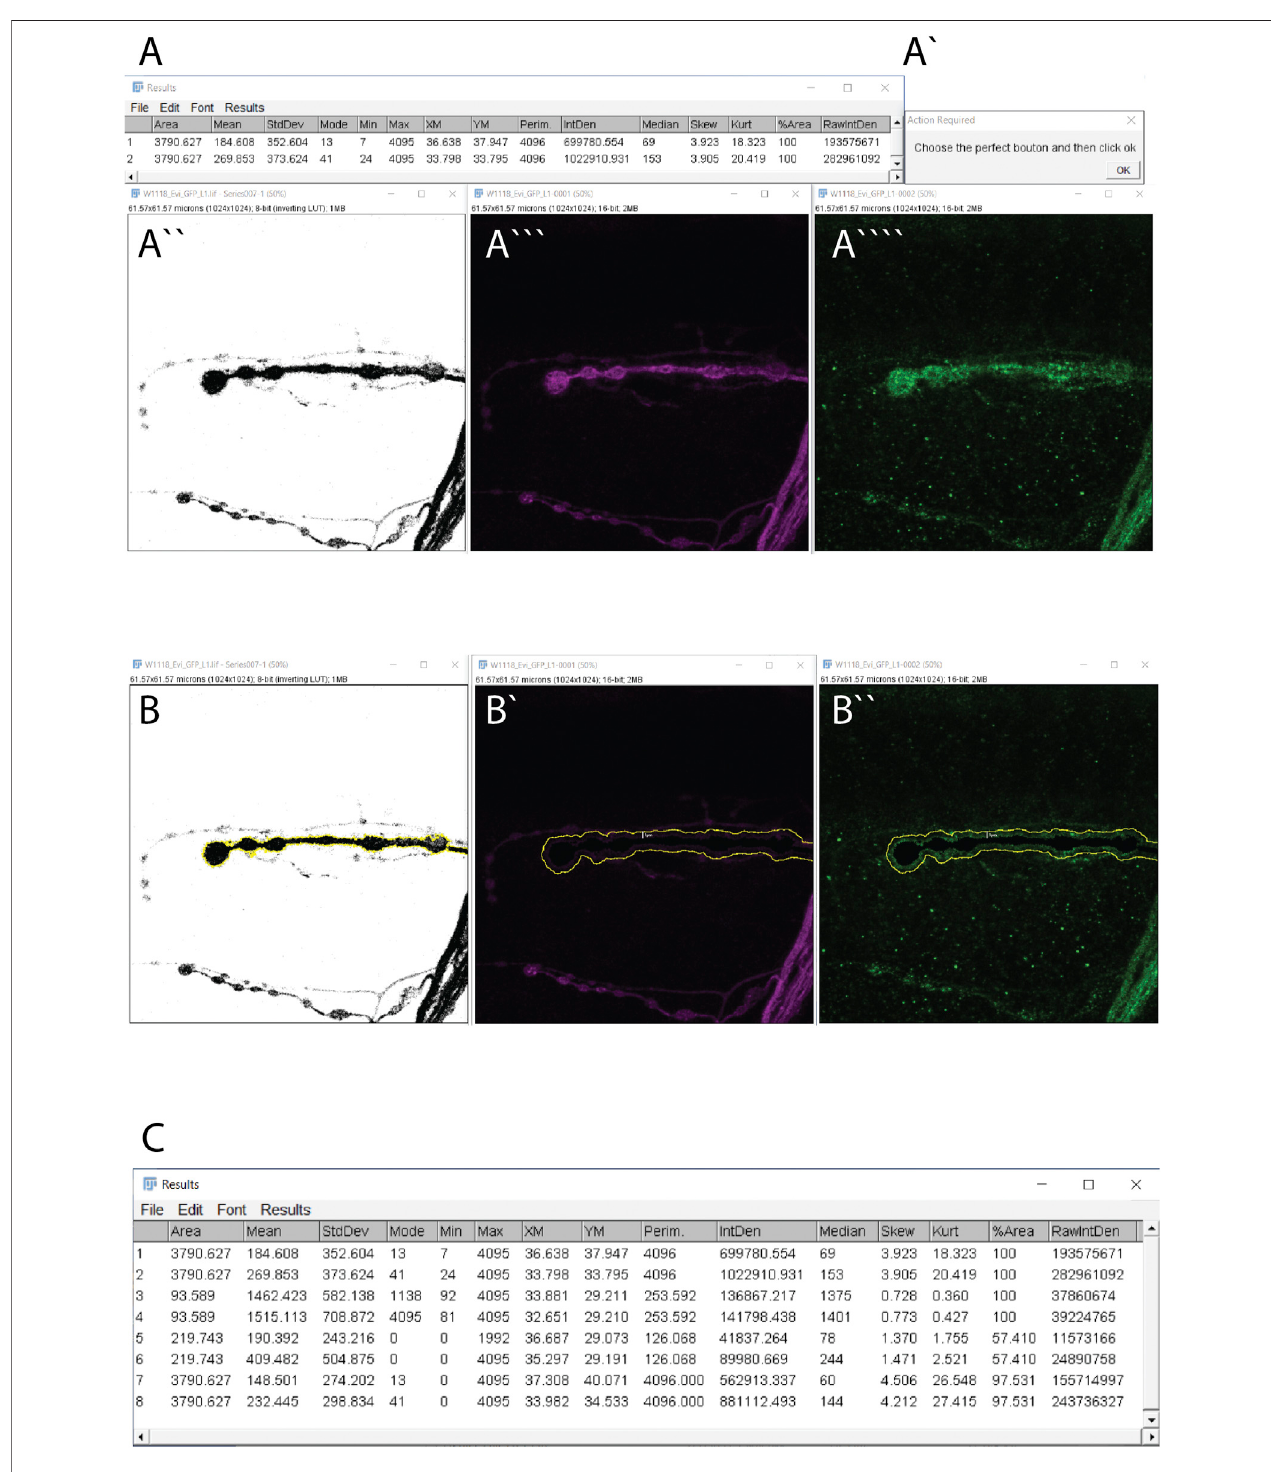
FIGURE 2 | Exoquant macro working steps and results. (A – A ”” ) The four windows results are obtained automatically when you run the macro. (A) The two lines with measurements from the raw data of the two channels. (A ’ ) The action window to detect the shape of the synapse. (A ’’ ) Image after the application of the Otsu algorithmtoautomaticallydetectthepresynaptic membranemarker(HRPchannel/outline). (A - ) OriginalimageofHRPand (A ”’’ ) Evi-GFPsignal. (B,B ” ) Thesewindows appear after con fi rming the synapse shape. (B) The neuronal membrane outline (yellow) that was selected in the previous step. (B ’ ) The neuronal membrane channelwiththeselectedsynapseinblackwithavalueof0andinyellowistheenlargementof1 μ mfromthepresynapse(imposedforclaritybutwillnotappear). (B ” ) The exosome signal with the neuronal presynapse selected in black with value 0 and in yellow the enlargement of 1 μ m from the neuron (imposed for clarity but will not appear). (C) The result